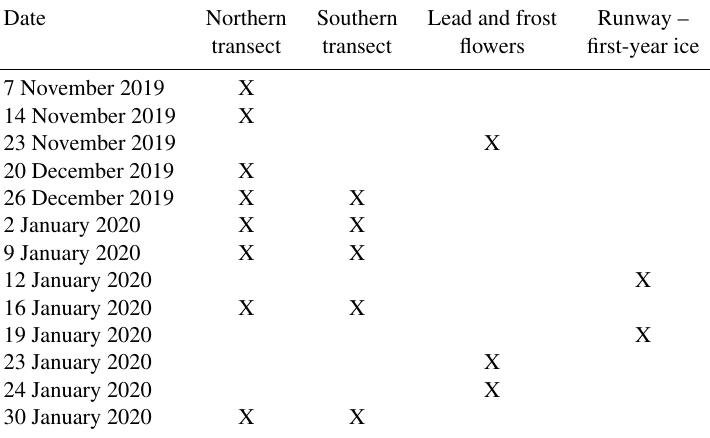
Table 3. Dates for when the northern and southern transects were conducted, in addition to dates when the instrument sampled lead and frost flowers as well as first-year ice at the runway